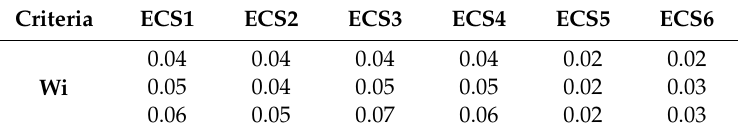
Table 10. Weights of criteria of economic sustainability.